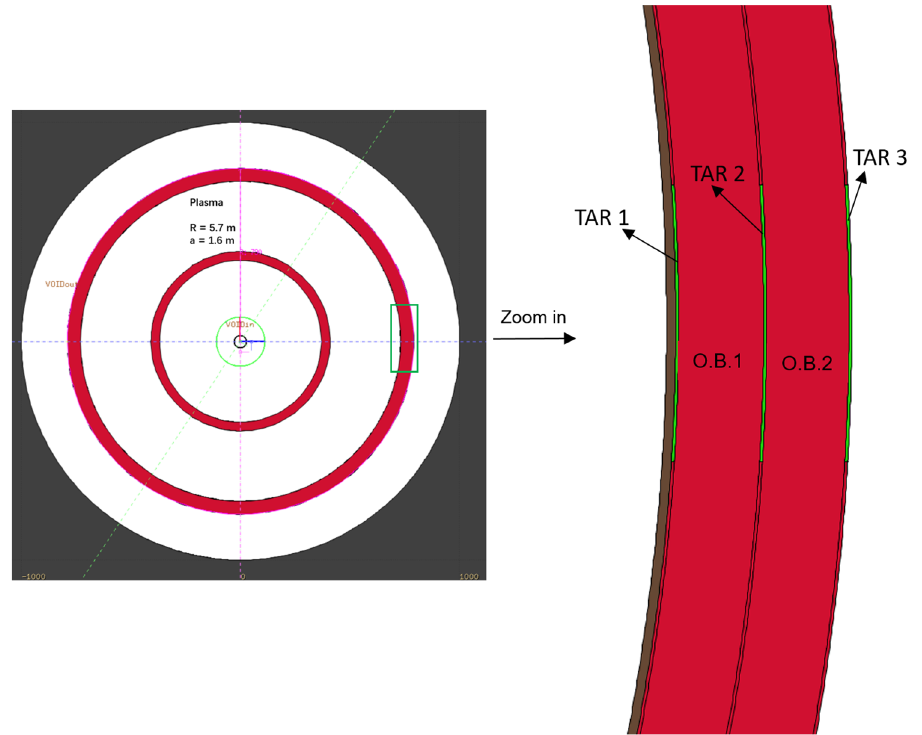
Figure 1. One-dimensional CFETR model (FLUKA modelling).